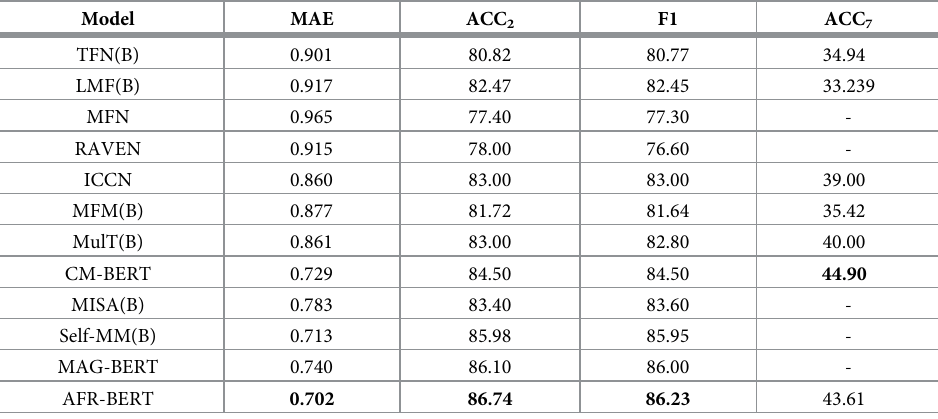
Table 4. Comparative experiments of multimodal sentiment analysis models on the dataset CMU-MOSI.